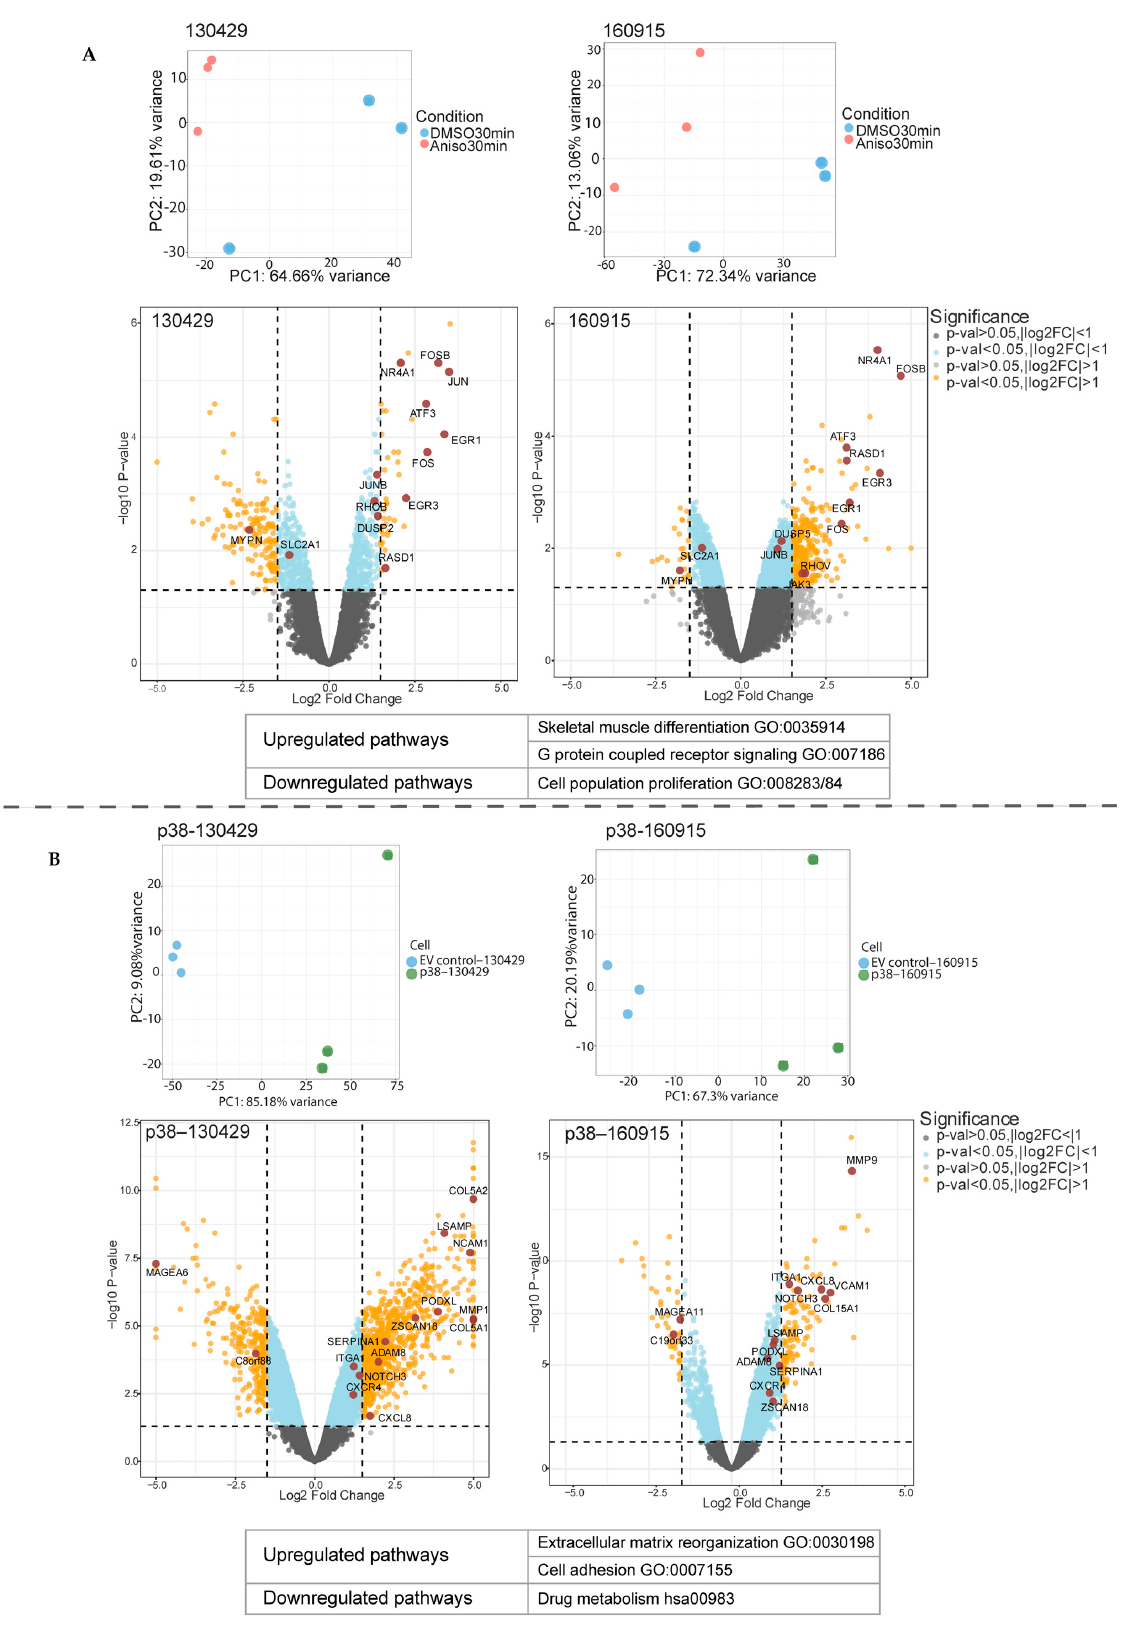
Figure 1. Distinct set of genes and pathways upregulated in the anisomycin-treated 130429/160915 cells and p38–130429/160915 cells. ( A ): Principal component analysis of 30 min